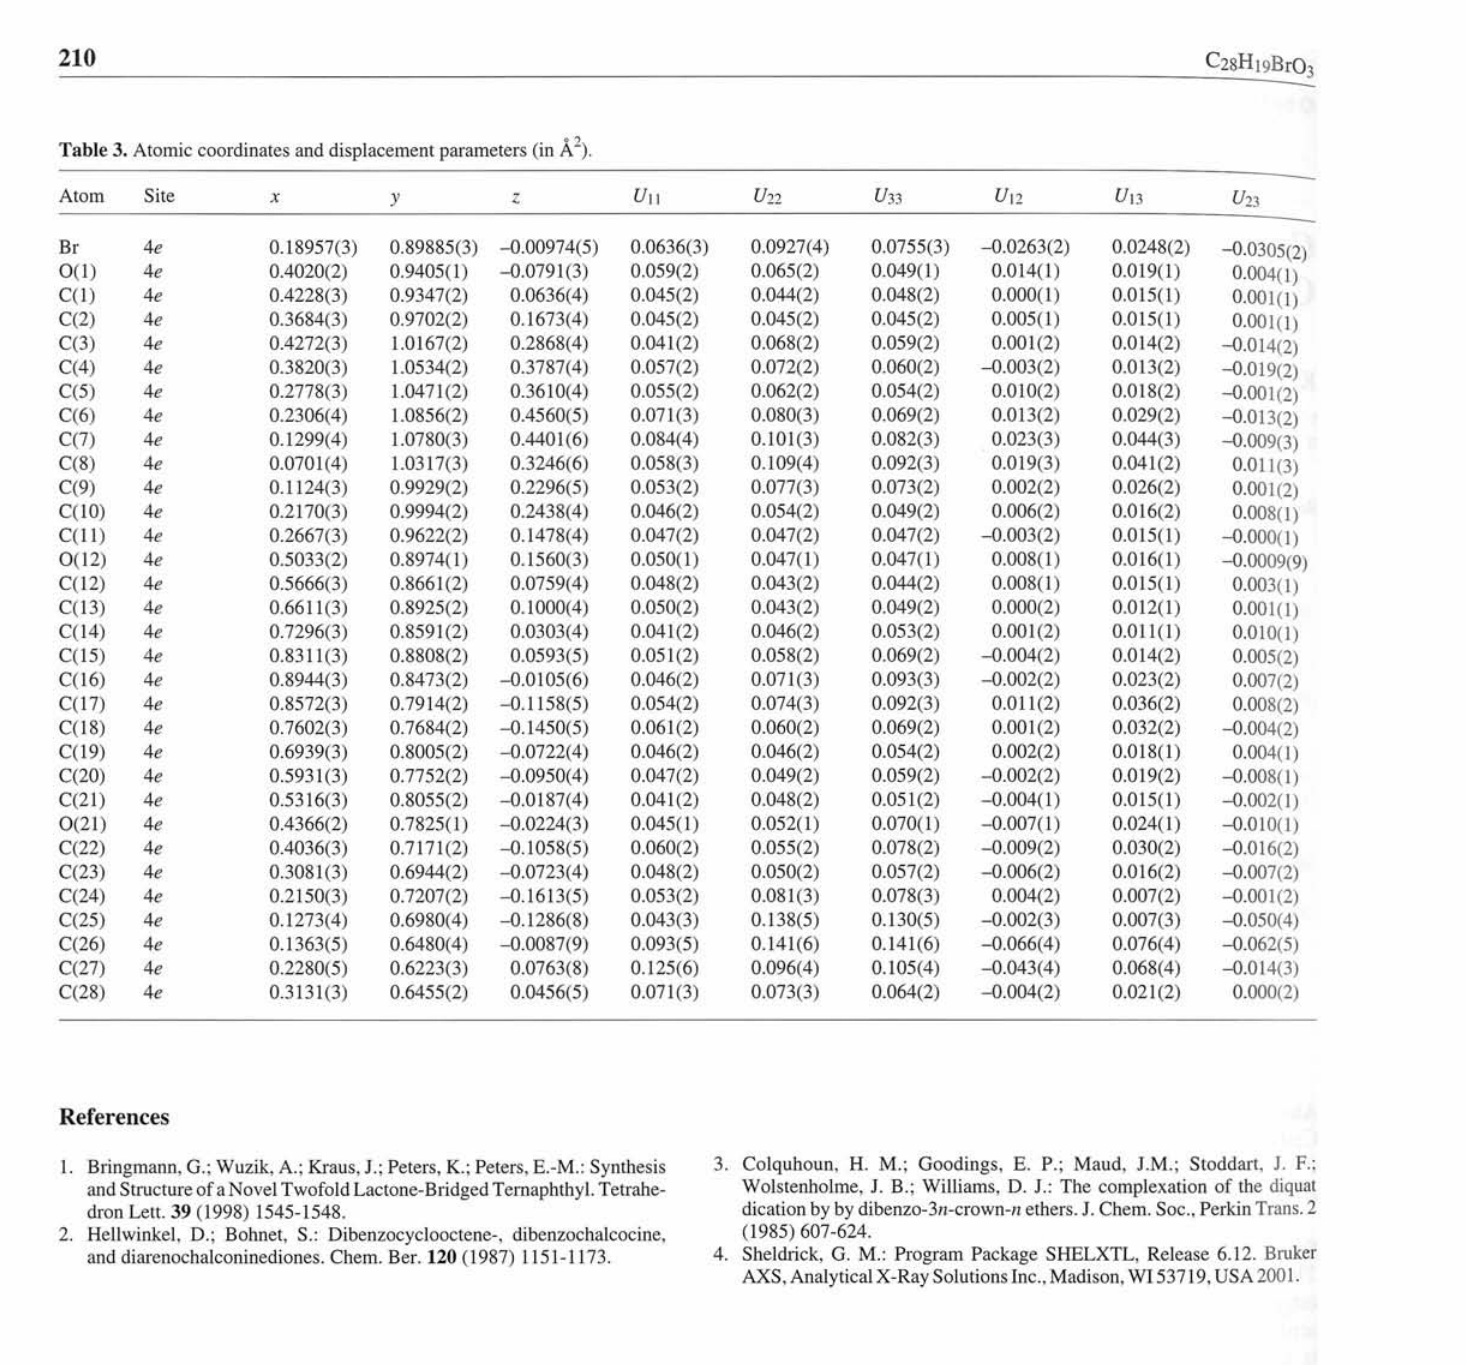
Table 3. Atomic coordinates and displacement parameters (in